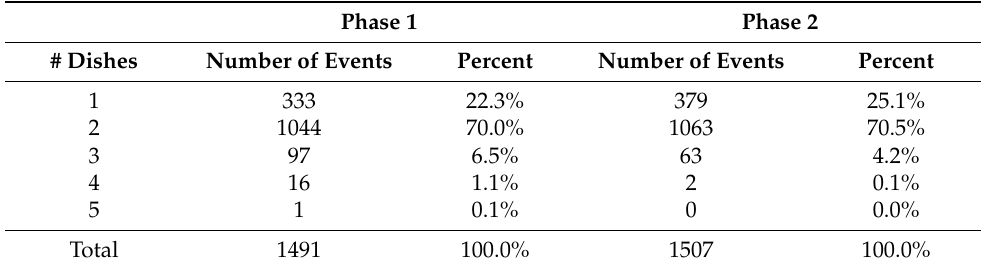
Table 8. Number of dishes included in a heating event (Phases 1 and 2—breakfast, lunch, and dinner heating events